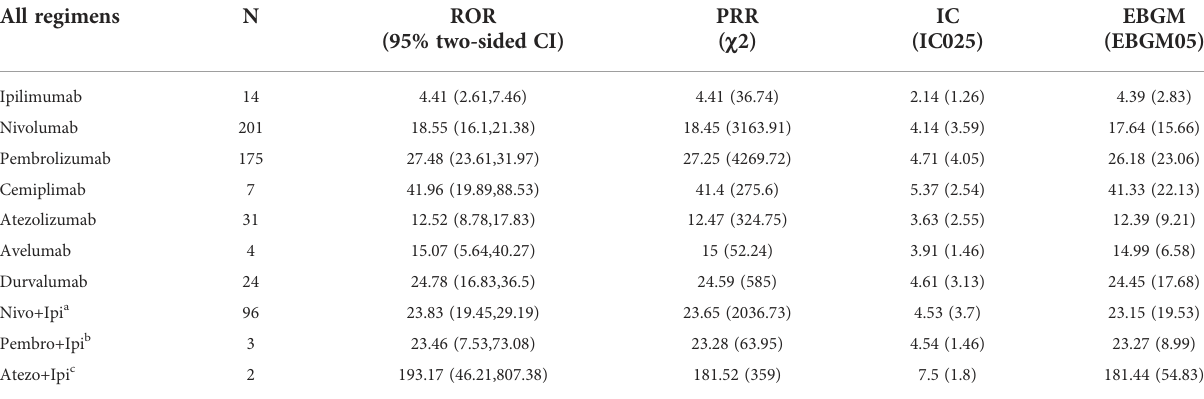
TABLE 4 Signal detection.